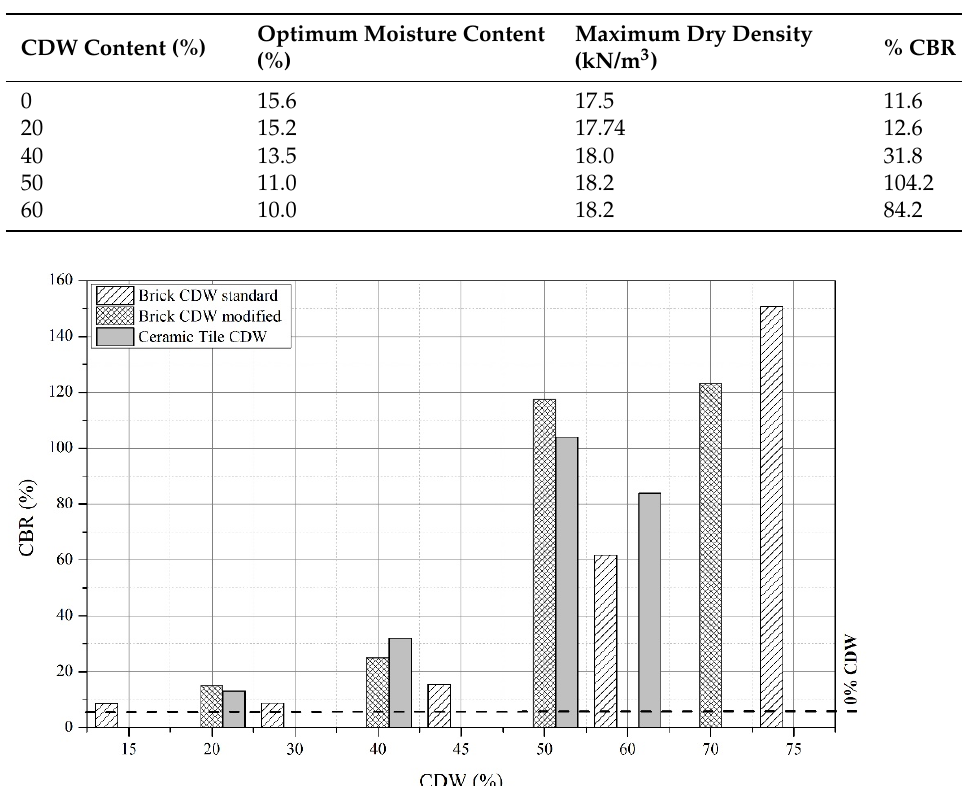
Table 6. CBR results with modified Proctor energy (56 blows) in soil mixes with ceramic CDW.